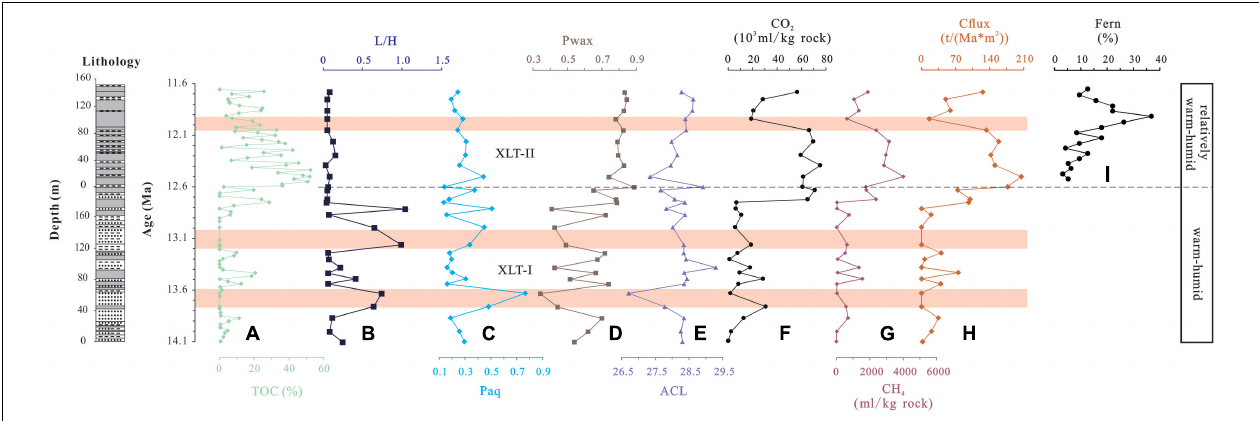
FIGURE 4 | Variations though time in various paleoenvironmental indicators for the Xiaolongtan Basin: (A) TOC contents, (B) L/H ratios, (C) Paq values, (D) Pwax values, (E) ACL values, (F) estimated production rate of CO 2 , (G) estimated production rate of CH 4 , (H) burial rate of organic carbon and (I) percentage of ferns in the Xiaolongtan Formation. Bars in this figure indicate three episodes of enhanced humidity inferred from lipid biomarkers and pollen